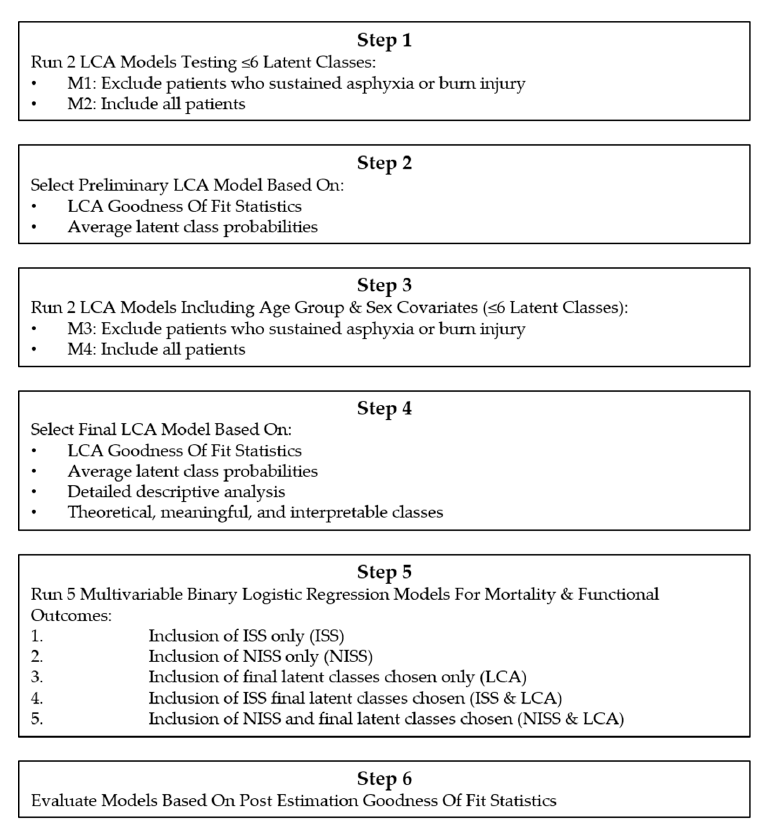
Figure 1. Flowchart of main analyses.